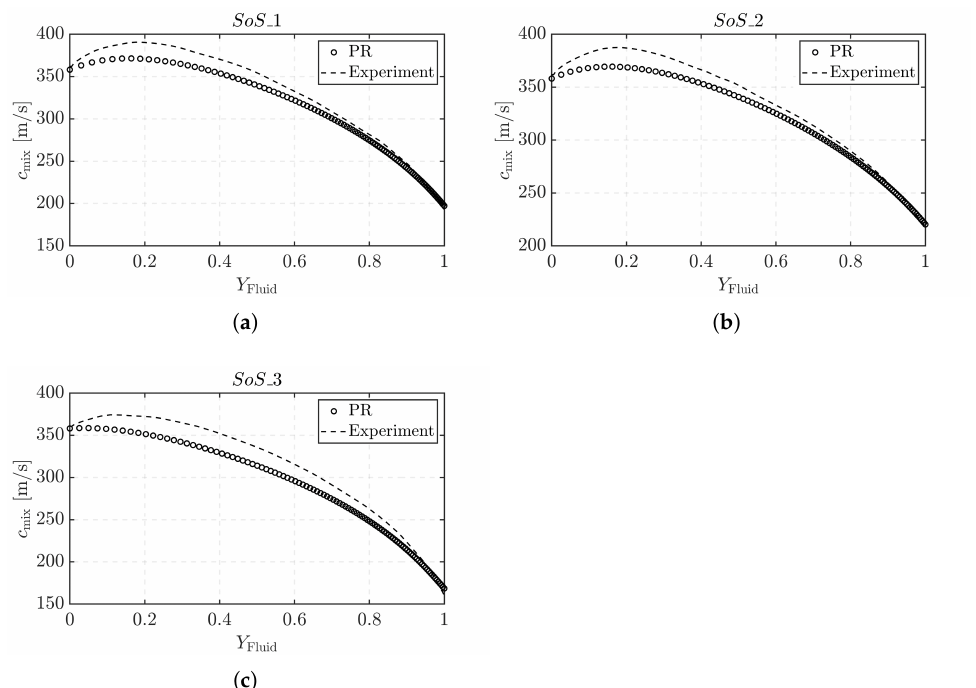
Figure 5. Mixture speed of sound as a function of the mass fraction of the injected fluid ( Y Fluid ) for SoS _1 ( a ), SoS _2 ( b ), SoS _3 ( c ). “PR” refers to the data obtained with our thermodynamic modeling approach and “Experiment" to the experimental reference data